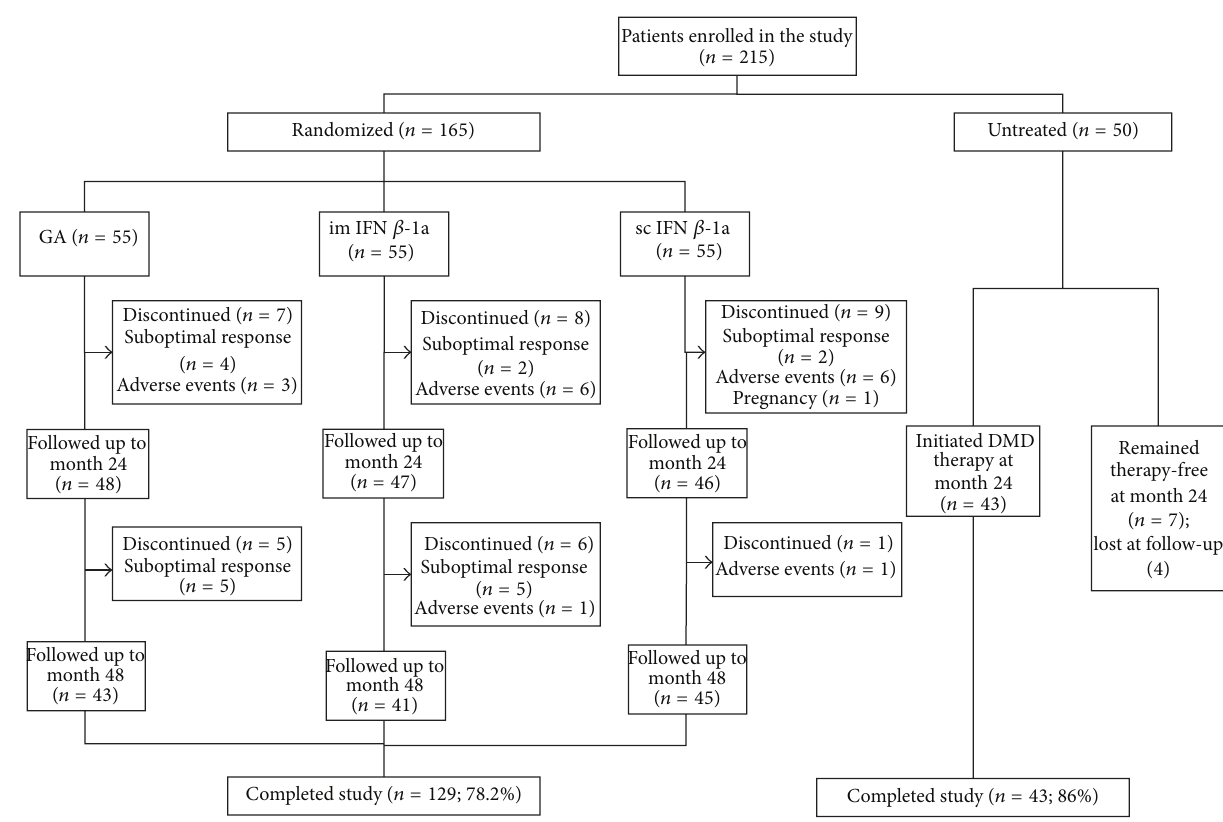
Figure 1: Patient enrollment, disposition, and follow-up. DMD: disease-modifying drug, GA: glatiramer acetate, IFN: interferon, im: intramuscular, and sc: